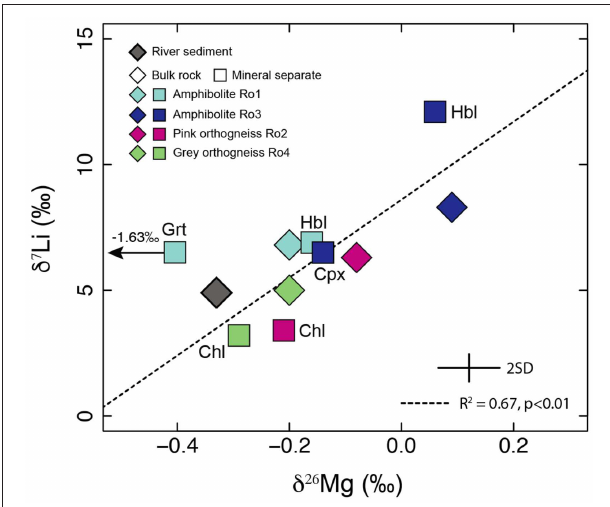
FIGURE 4 | Excluding garnet, where Li and Mg may be held in sites with different coordination numbers, a positive relationship is observed between the δ 26 Mg and δ 7 Li values of the rocks (diamonds) and mineral separates (squares). Mineral abbreviations are: Grt, garnet; Hbl, hornblende; Chl, chlorite; Cpx,